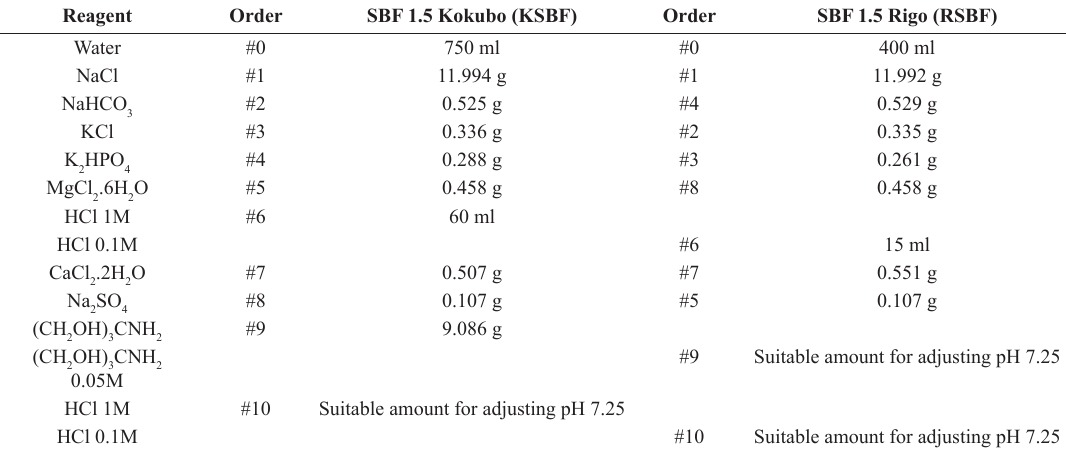
Table 2. Reagent content for preparing the simulated body fluid (SBF) solutions (1L) according to the literature 11,16 .